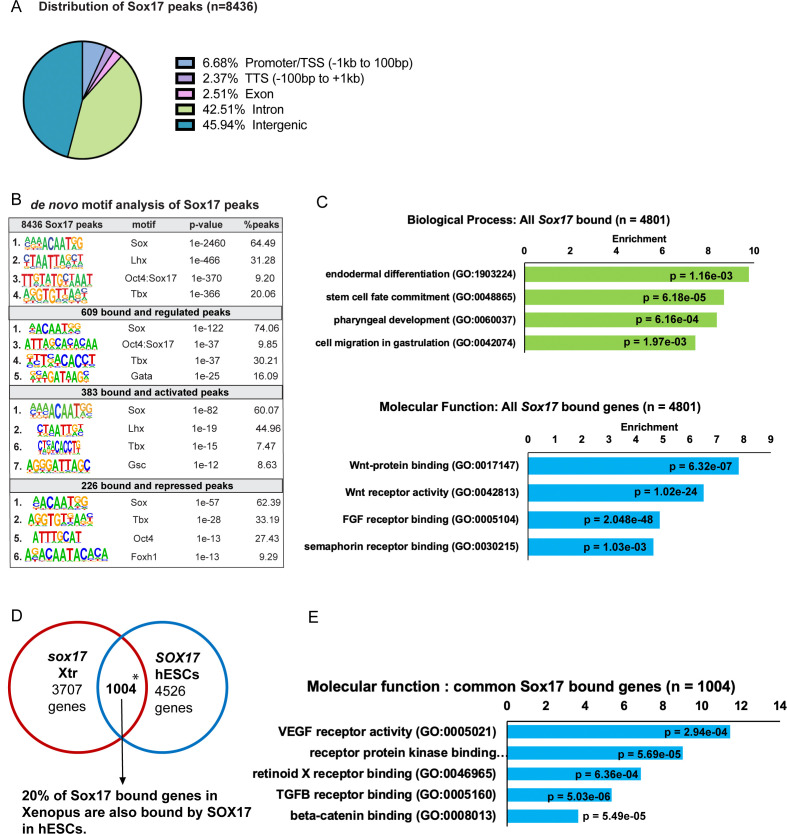
Analysis of Sox17-bound chromatin loci.(A) Genomic distributions of 8436 Sox17-bound ChIP-seq peaks associated to cognate promoters using HOMER. 88% of the Sox17 peaks were located in either introns or elements more than 1 kb from the TSS, indicative of distal CRMs. (B) De novo DNA-binding motif enrichment analysis of Sox17 peaks associated with Sox17-regulated genes by HOMER hypergeometric test. (C) GO analysis of 4810 genes associated with Sox17 ChIP-seq peaks showed enrichment for endoderm development and Wnt signaling. Fold enrichment by Fisher’s exact test with p-values adjusted to 5% FDR for multiple testing correction (D) Comparison of the Xenopus genes associated with Sox17 ChIP-seq peaks to published human SOX17 ChIP-seq from human embryonic stem cell (hESC)-derived definitive endoderm (GSE61475; Tsankov et al., 2015). The extensive overlap between Xenopus and human Sox17-bound genes (*p<0.001 by hypergeometric test) indicates that Sox17 regulates an evolutionarily conserved GRN. The intersection only includes Xenopus genes that have human orthologs, unannotated Xenopus genes were excluded from the analysis. (E) GO term enrichment analysis of the 1004 Sox17-bound genes conserved between Xenopus and human by Fisher’s exact test with p-values adjusted to 5% FDR for multiple testing correction.